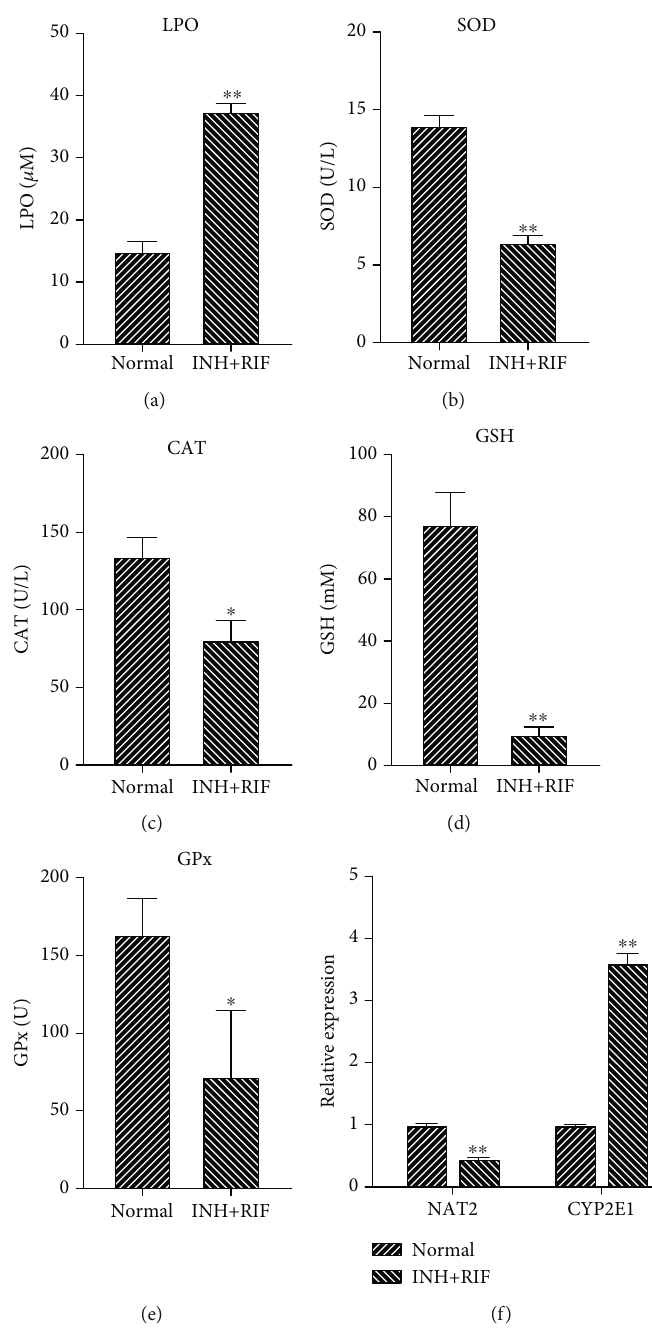
Figure 2: INH and RIF markedly regulated the OS-antioxidant defense system and drug-metabolizing enzymes in rats. (a – e) The OS indices (LPOs) and levels of antioxidant enzymes (SOD, CAT, GSH, and GPx) in rats treated with INH and RIF were determined using speci fi c commercial kits. (f) QRT-PCR analyses of NAT2 and CYP2E1 in the liver tissues of rats treated with INH and RIF. ∗ P < 0 : 05 and ∗∗ P < 0 : 01 vs. the normal